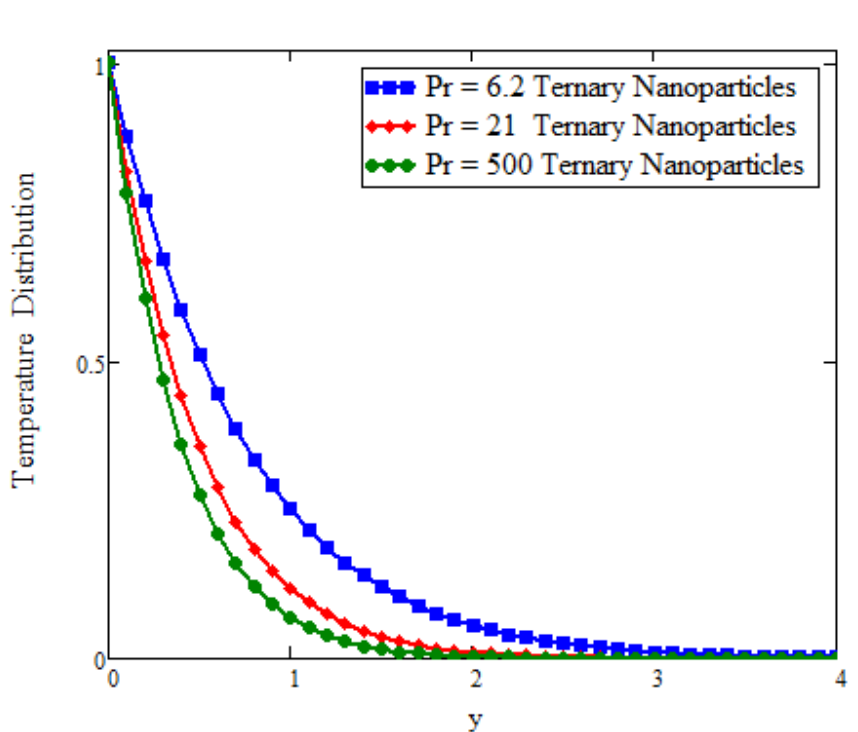
Figure 4. Comparison of temperature assessment with Pr across y as α = 0.5, β = 0.5, and γ = 0.5 when t = 0.04 and Sc = 1.5.